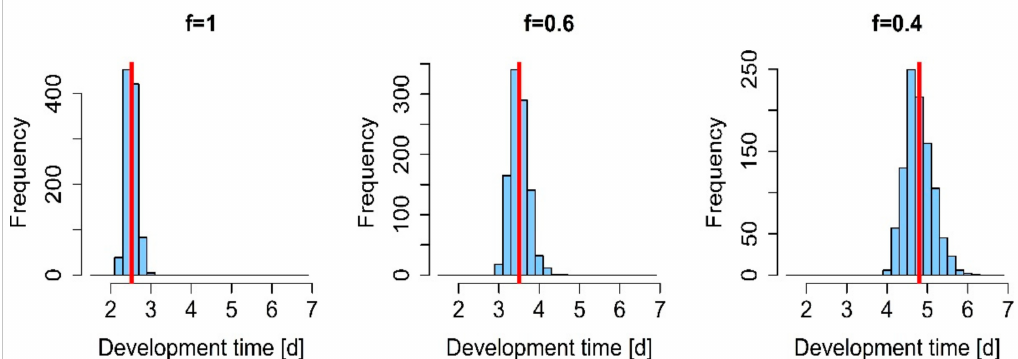
Figure 3. Simulated development times in days (d) (n = 1000) for the example of the fifth larval instar reared at 26 ◦ C and three different feeding regimes: Ad libitum (f = 1), intermediate (f = 0.6), and low (f = 0.4) food availability. Blue columns represent the frequencies of the development times of larvae (n = 1000), and the red vertical line indicates the mean development time per